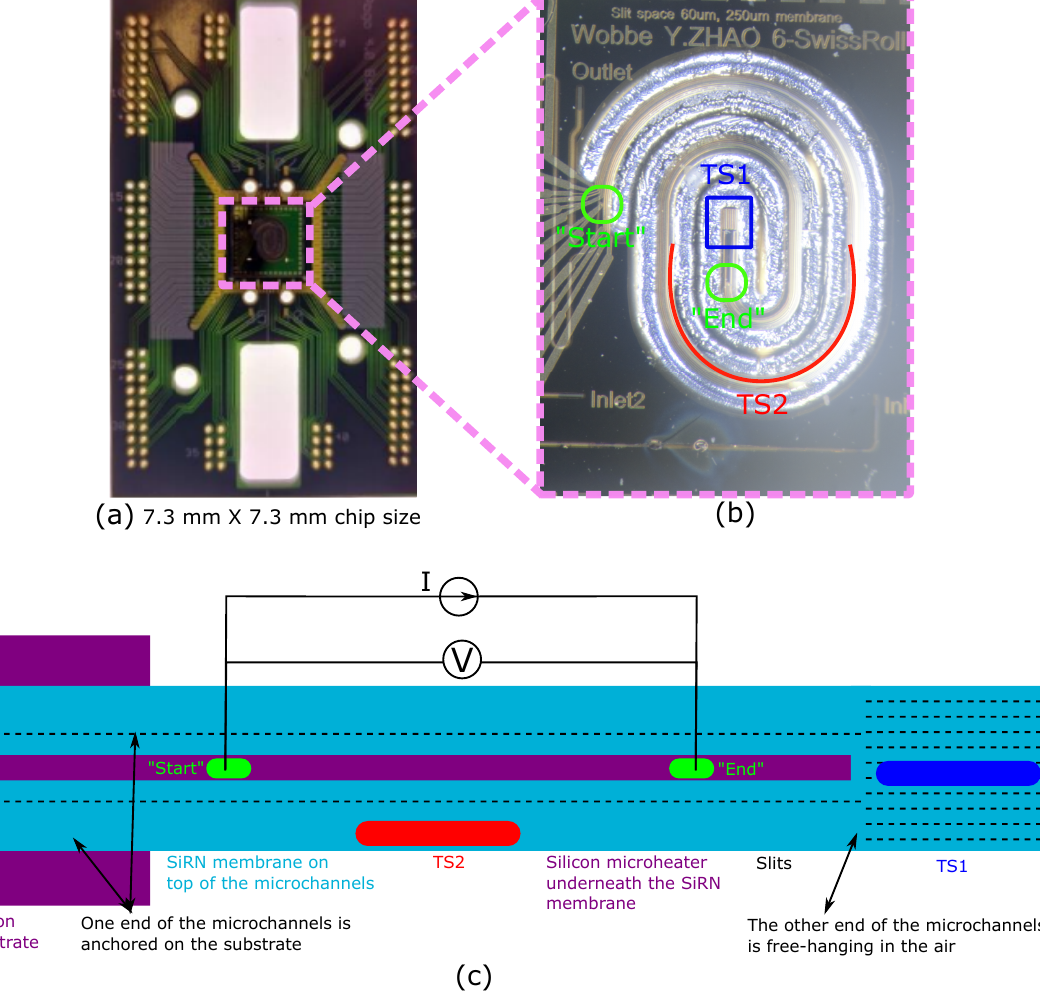
Figure 10. Photographs of ( a ) a demonstrator chip mounted on a printed circuit board and ( b ) a close-up of the swissroll-shaped channels in the demonstrator chip. A schematic drawing is shown in ( c ), representing the swissroll-shaped channels by a straight